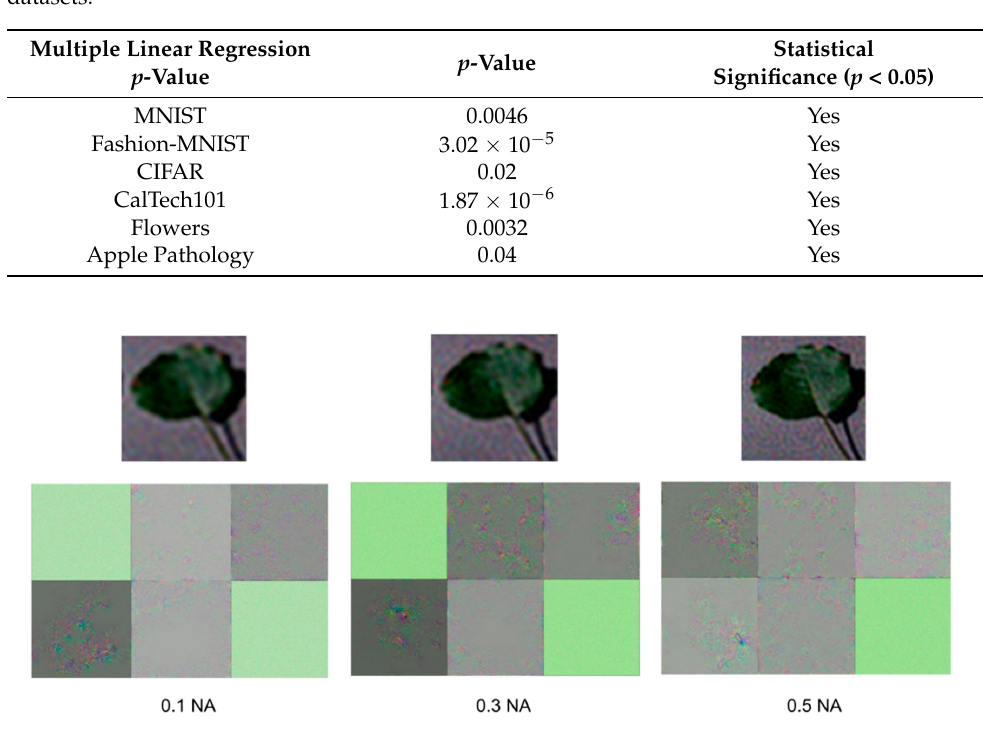
Figure 12. Visualization of the apple pathology images and Google inception convolution neural network activation map (gradient) at the 141st layer. In total, the Google inception convolution neural network had 144 layers. The 141st layer is followed by the fully connected layer, the softmax layer, and the output layer. The green color corresponds to the vanished gradient. Fewer features in the activation map corresponds to the reduction in gradient.